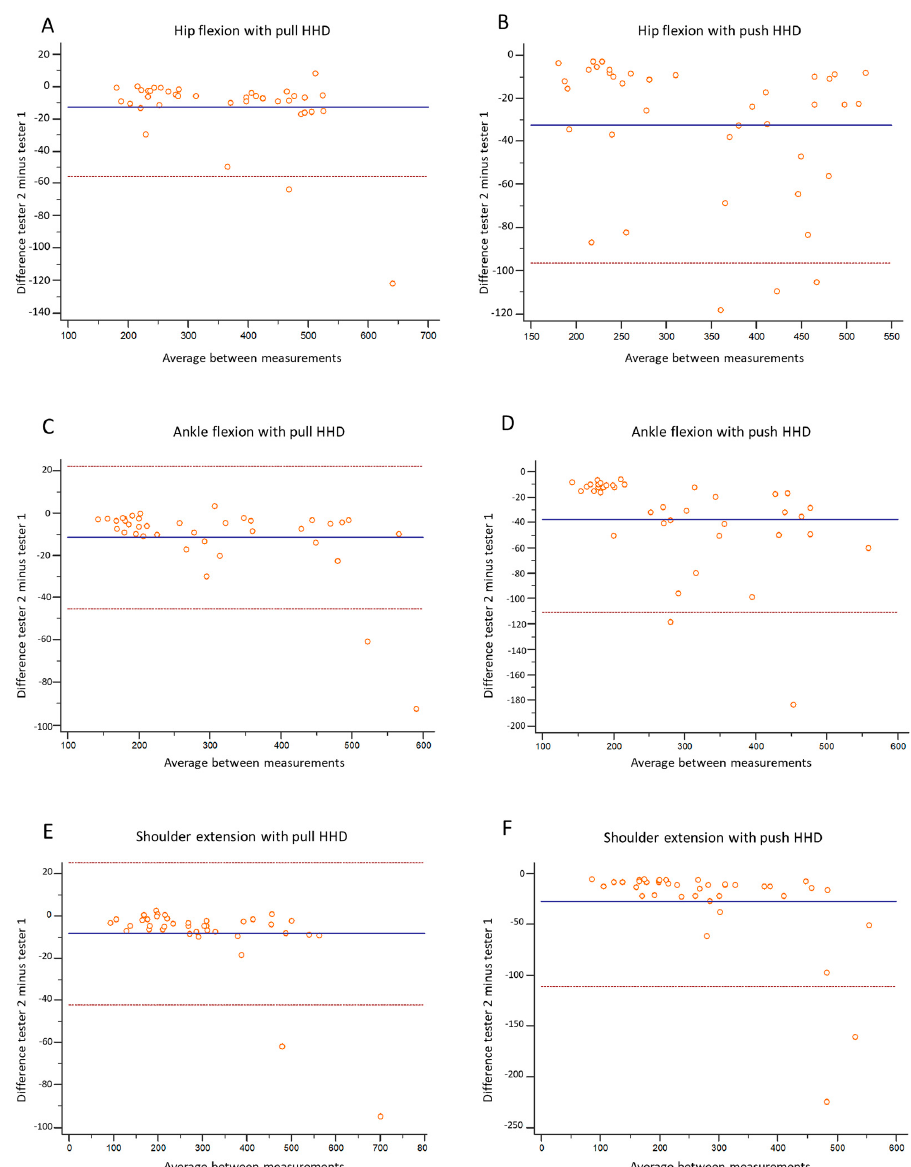
Figure 3. Bland Altman plots of the rater differences for pull HHD ( A , C , E ) and push HHD ( B , D , F ) methods as a function of total strength obtained in hip flexion ( A , B ), angle flexion ( C , D ), and shoulder extension ( E , F ).